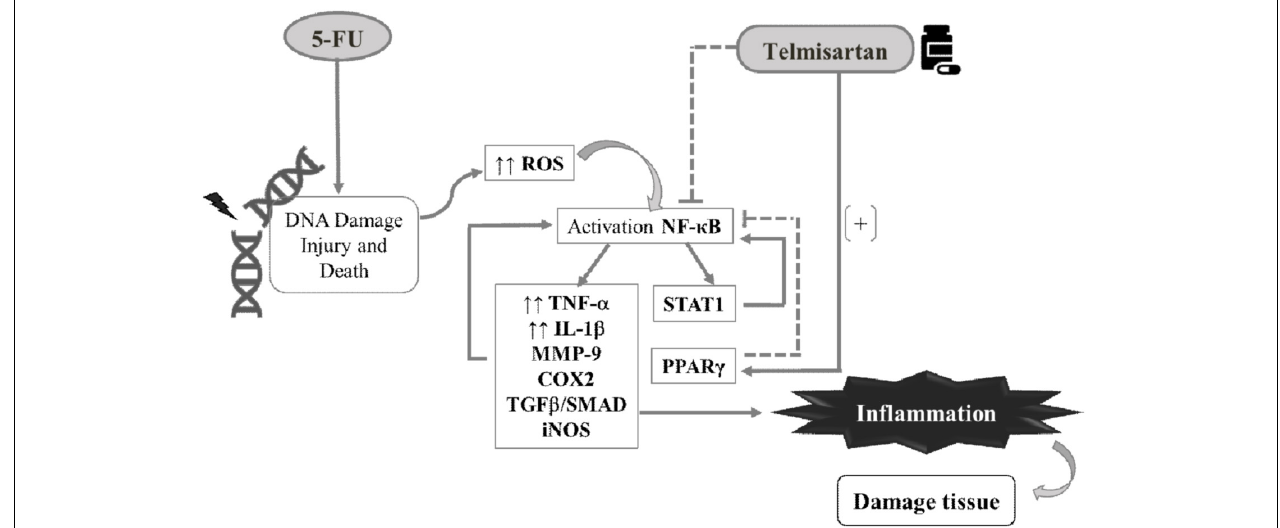
FIGURE 8 | Pharmacological modulation of the oral mucositis induced by 5-fluorouracil (5-FU) by telmisartan. DNA damage due to 5-FU activates NF κ B, and this nuclear factor induces the expression of proinflammatory cytokines such as IL-1 β and TNF- α which promote inflammation in the oral mucosa and tissue damage. Telmisartan interferes with NF κ B p65 to decrease IL-1 β , TNF- α , MMP-9, COX2, TGF- β , Smad 2/3, and iNOS improving oral mucositis. Telmisartan reduces NF κ B by decreasing STAT 1 gene expression, in addition to increasing the gene expression of PPAR γ . ROS, reactive oxygen species; NF κ B p65, nuclear transcription factor kappa B; STAT 1, signal transducer and activator of transcription 1; PPAR γ , peroxisome proliferator-activated